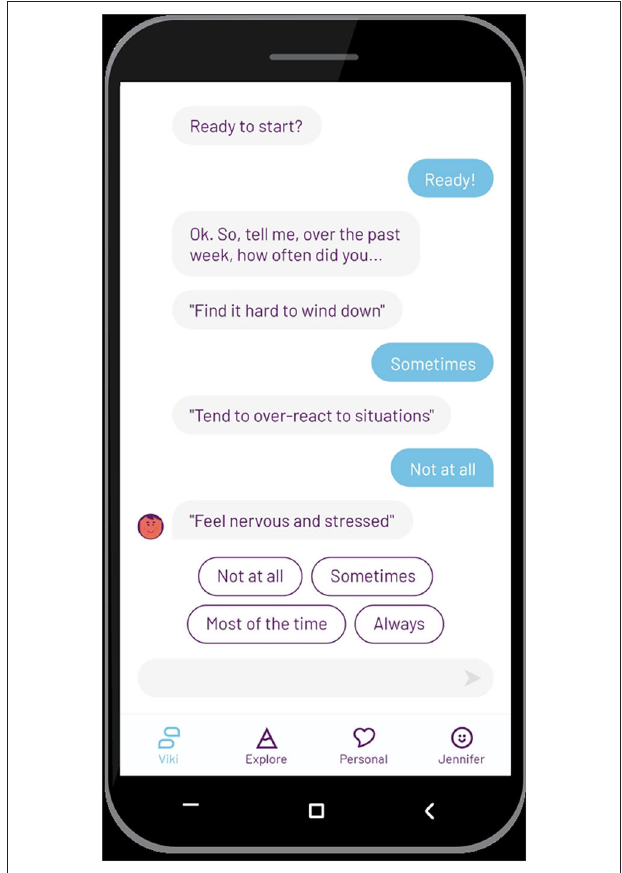
FIGURE 1 | Screenshot of Vitalk